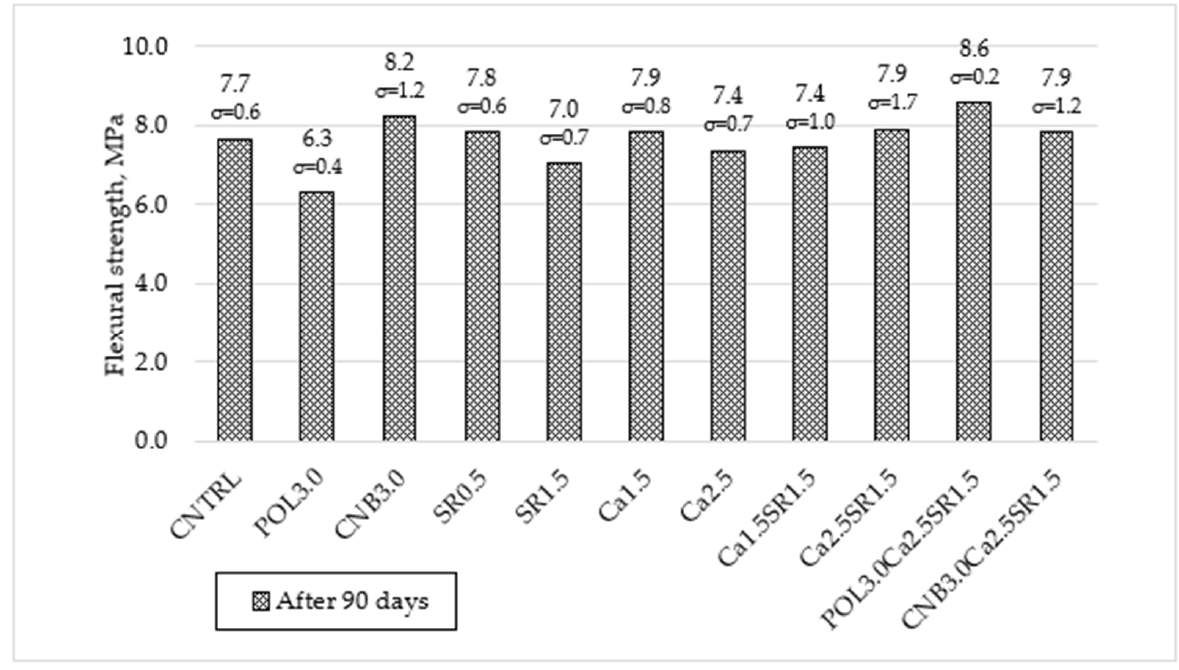
Figure 6. The change in flexural strength of concrete. Reference specimens (CNTRL) without additives had the average flexural strength of 7.7 MPa. The incorporation of polypropylene fibers in concrete had contradictory